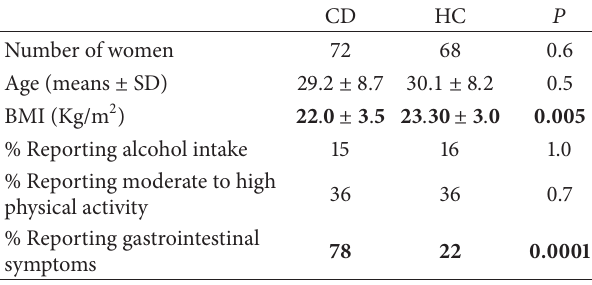
Table 1: Basic characteristics of the study population. Table 2: Profile of celiac disease (CD) and healthy controls (HC) groups according to EDI-2 scores in women in Table 2(a) and men in Table